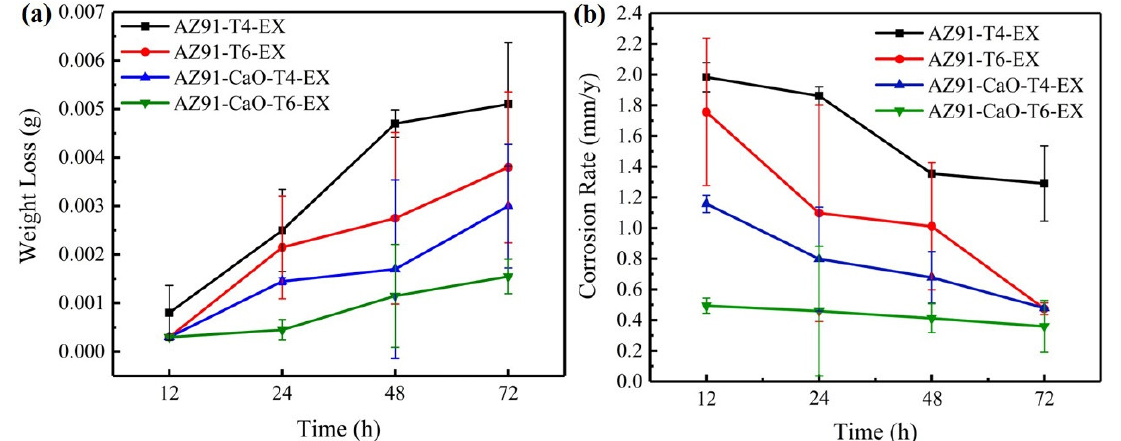
Figure 9. Salt spray corrosion of extruded AZ91 and AZ91-CaO at different times under different conditions: ( a ) weight loss, ( b ) corrosion rate.